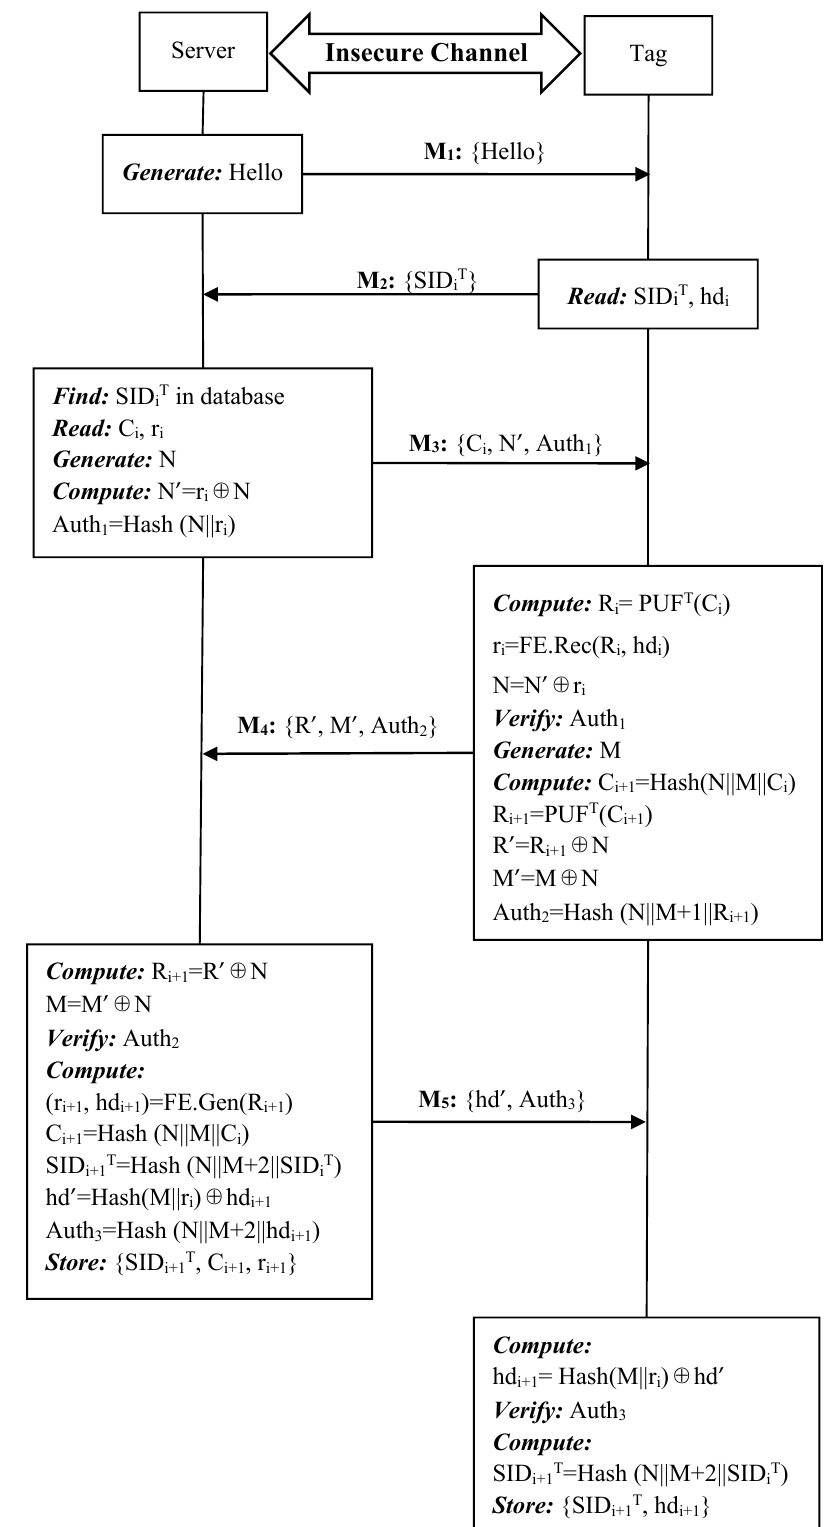
Figure 7. Authentication phase of the proposed noisy PUF-based protocol.